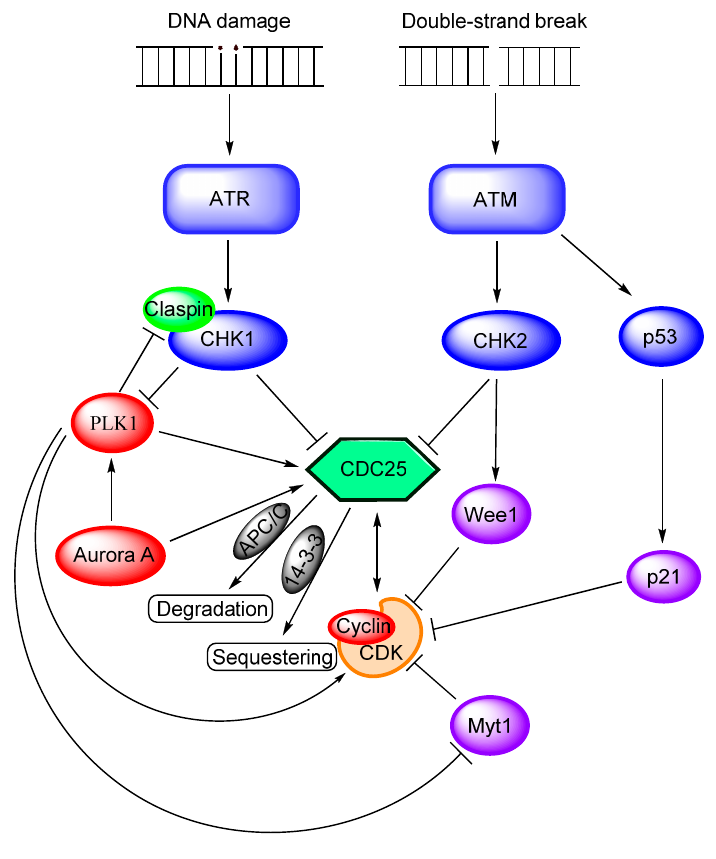
Figure 3. Molecular interactions that regulate CDC25 activity (for simplicity reasons the effects of PI3K-Akt-mTOR signaling are described in the text but not included in the figure). The CDC25 activators are shown in red, the upstream inhibitors in blue and the downstream regulators in purple. Note that the CDC25s and the CDKs mutually activate each other. PLK1 is a key component as it positively regulates CDC25s and two of their activators, as well as it inhibits Myt1 and mediates the degradation of claspin. The key components for down-regulation of CDC25s are ATR and ATM. CDC25s are also prone to degradation by APC/C-dependent ubiquitination and nuclear exclusion by 14-3-3 binding. See text for further